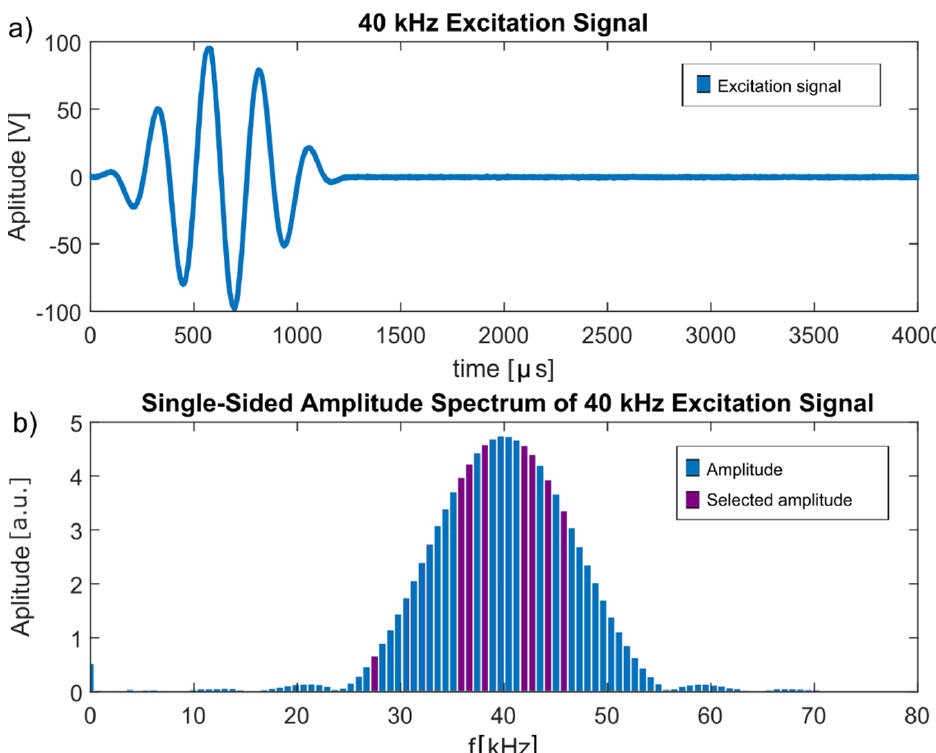
Figure 7. ( a ) 40 kHz excitation signal. ( b ) Single-sided amplitude spectrum of the 40 kHz excitation signal. Purple bars indicate the frequencies selected by the improved algorithm of the automated toolbox.